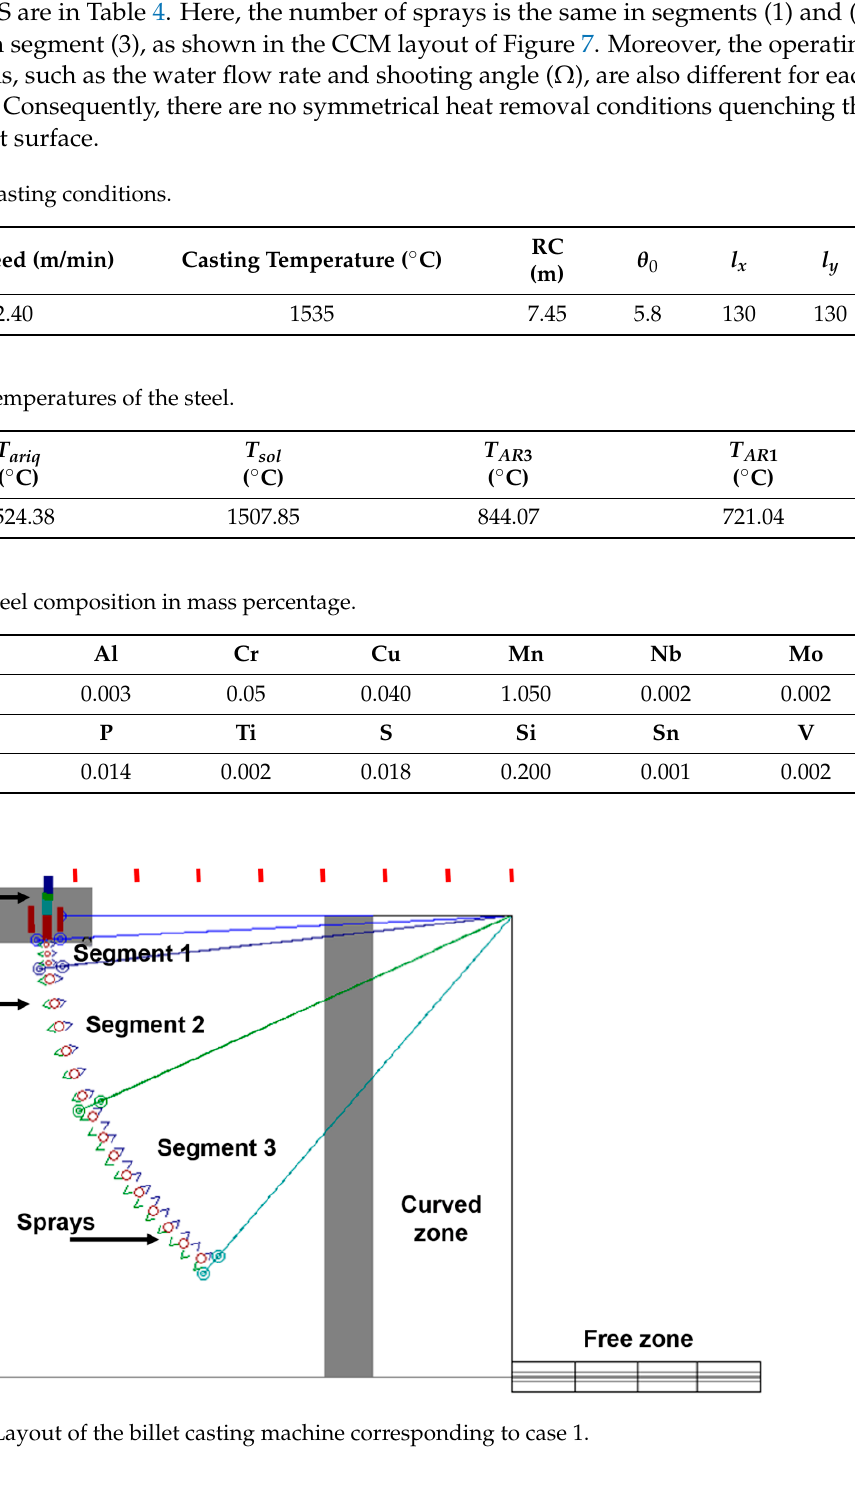
Figure 8. ( a , b ) Temperature on the billet surfaces due to the symmetrical heat removal applied (consequence of a non- symmetrical spray distribution and differential water flow rates). The temperature on the billet surfaces became different in the segments of the SCS because of the different heat removal conditions applied. There was the same number of sprays in the first and second segments in the lateral and casting directions but the water flow rates were different. Consequently, different curves diverged at the end of the mold